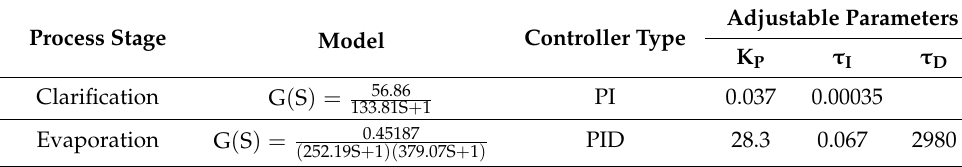
Table 2. Transfer functions of each of the stages.